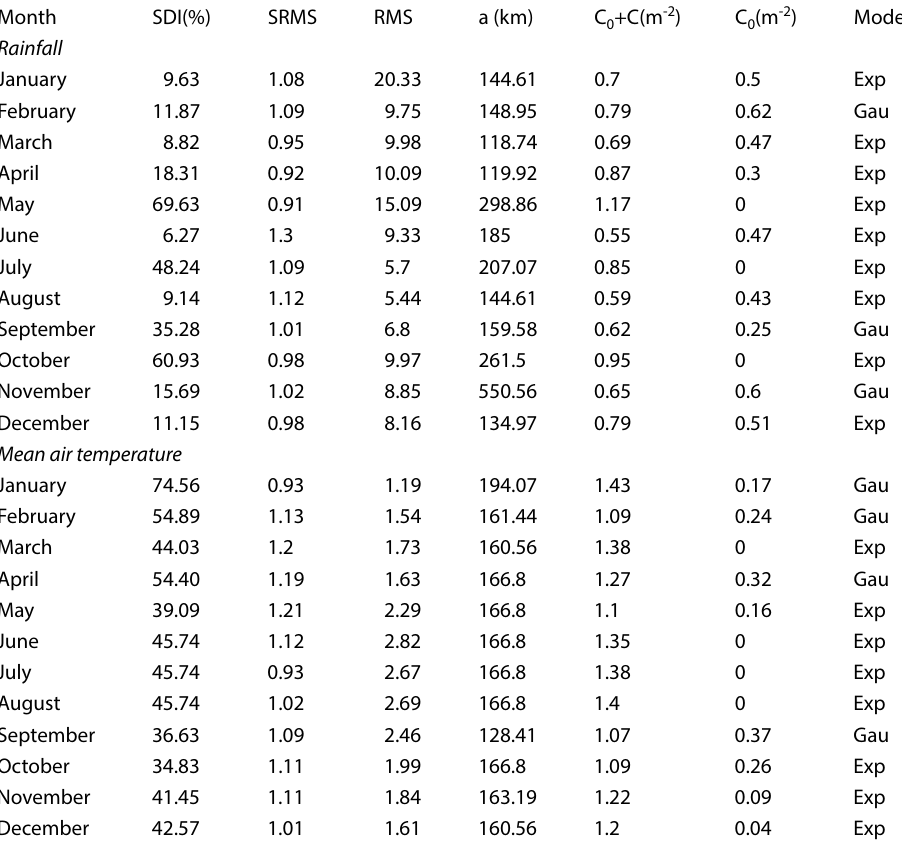
Table 3 Models and parameters of variogram for monthly mean rainfall and mean air temperature